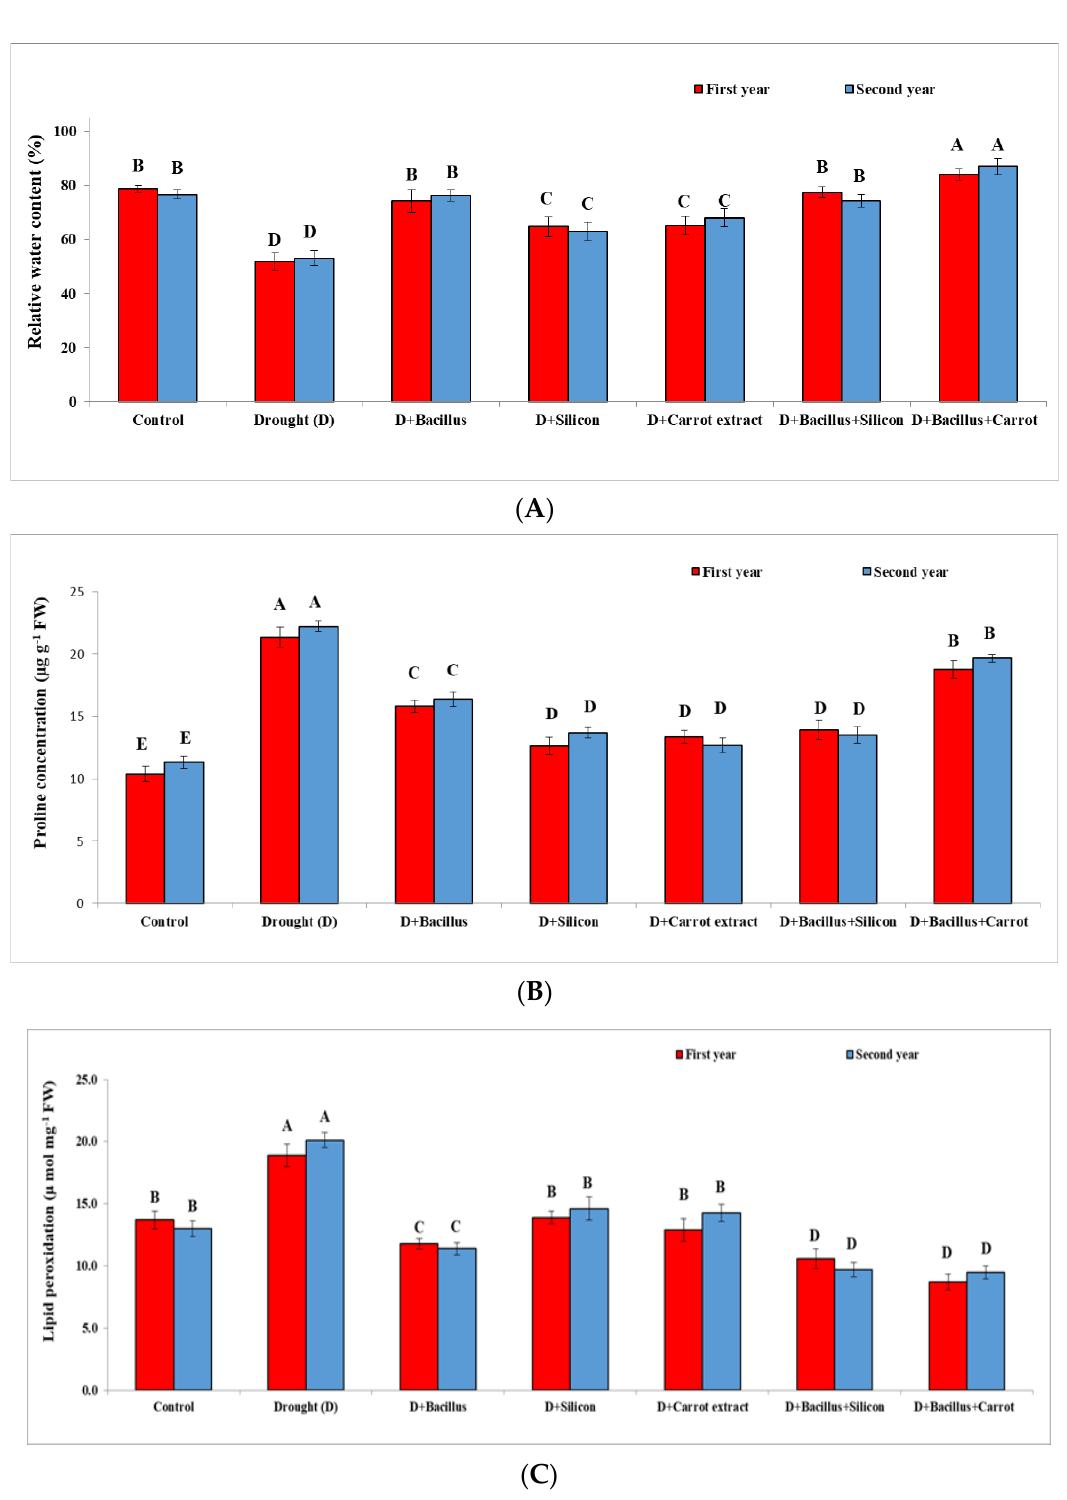
Figure 5. Effect of Bacillus thuringiensis , silicon, and carrot extract on relative water content ( A ), proline concentration ( B ) and lipid peroxidation ( C ) of drought-stressed pea plants during 2019/2020 and 2020/2021 seasons. Different letters on the columns show significant differences between the treatments according to ANOVA, and Duncan ’ s post hoc test when the result of the omnibus multivariate F-test in ANOVA was significant ( p ≤ 0.05). Data is the mean (± SE) of five replicates.